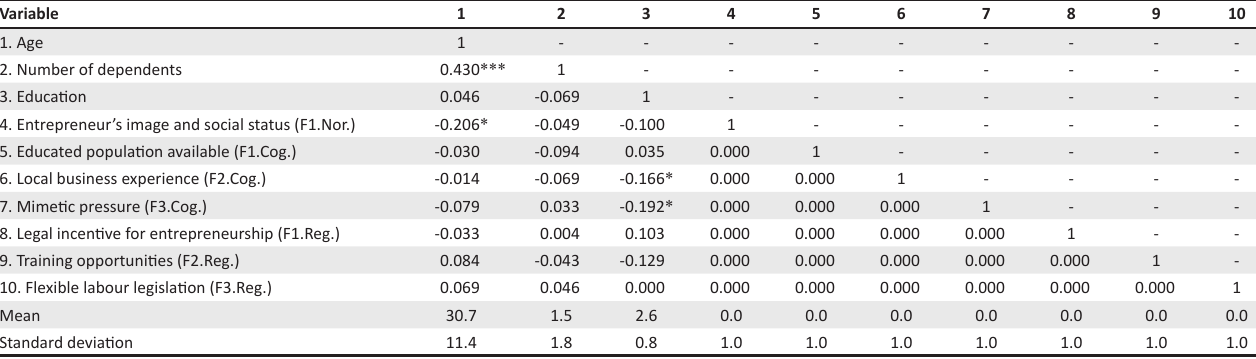
TABLE 3: Correlations, means and standard deviations: Entrepreneurs subsample. Variable